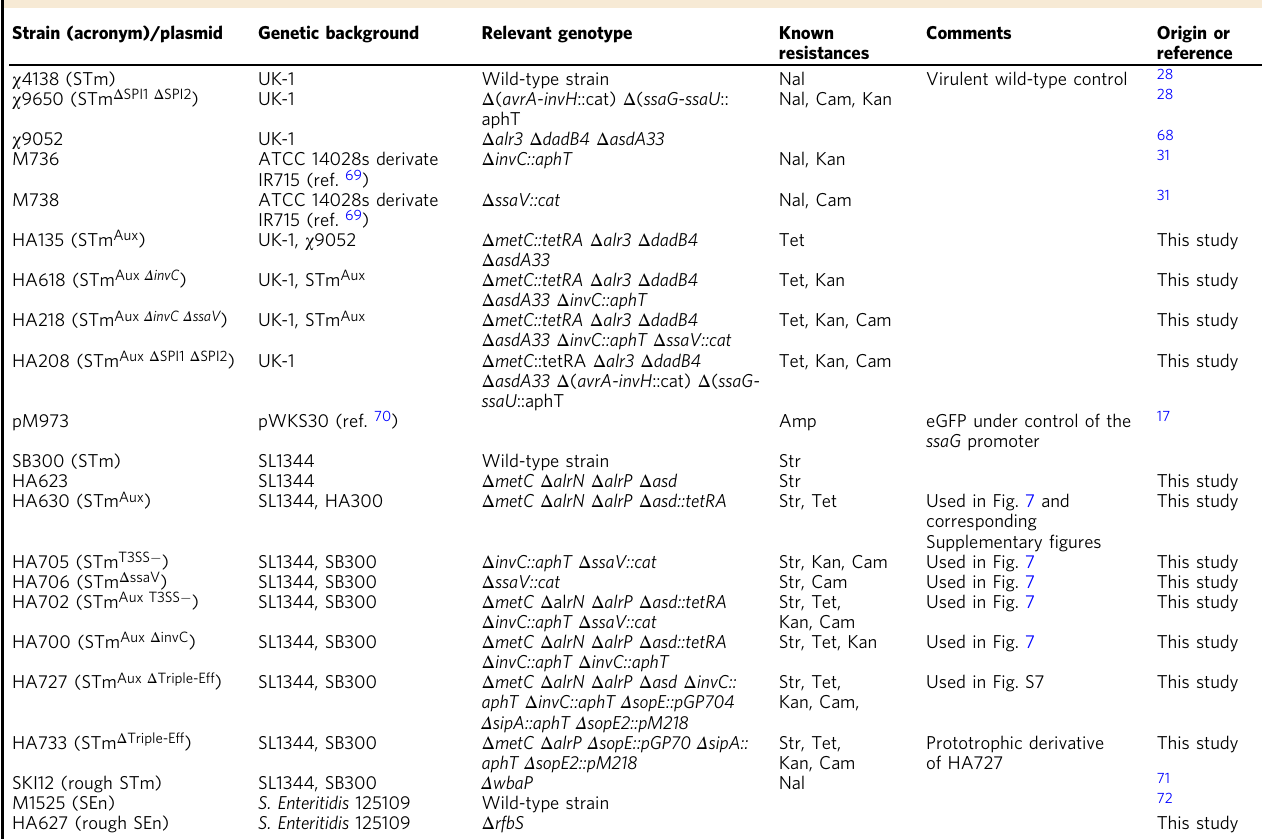
Table 1 Bacterial strains and